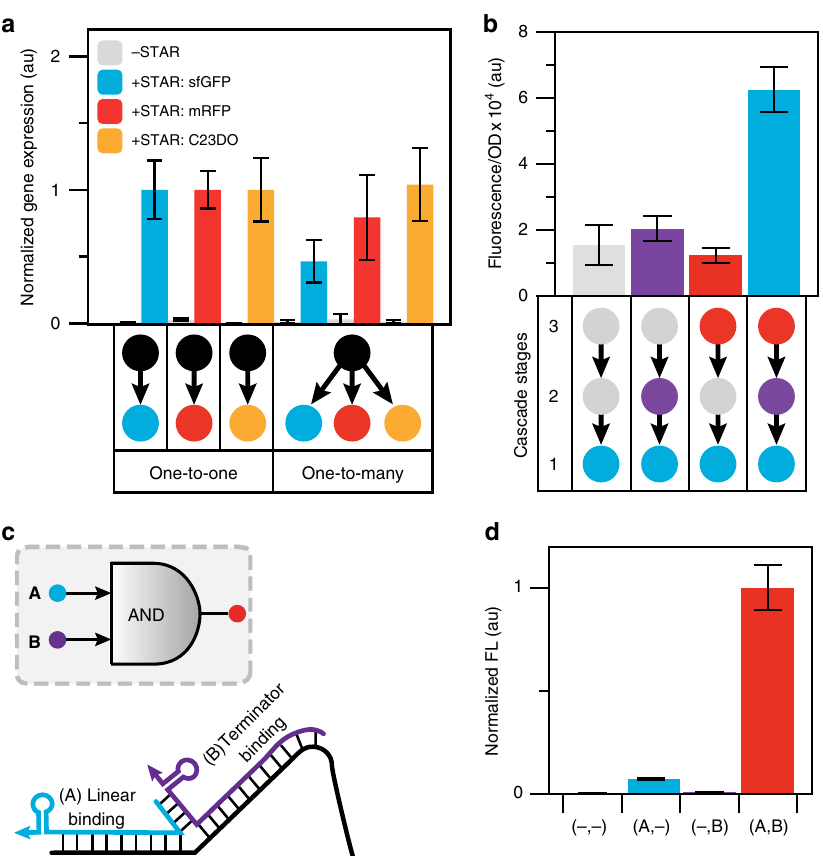
Fig. 5 STARs allow for new RNA-only network motifs. a A STAR single-input module (SIM) for one-to-many gene regulation. Fluorescence and spectral characterization of E. coli cells transformed with DNA plasmids encoding target RNAs controlling sfGFP, mRFP or catechol (2,3)-dioxygenase (C23DO) expression in the absence (-STAR) and presence (+STAR) of a plasmid encoding the cognate STAR. One-to-one characterization was performed on three different cell strains transformed with one of the plasmids encoding a single STAR regulated gene with and without the STAR plasmid. One-to-many characterization was performed on a single strain transformed with two plasmids encoding all three STAR regulated genes simultaneously with and without the STAR plasmid. C23DO expression level was determined as described in Supplementary Fig. 18. Measurements for each gene were normalized to 1 for the one-to-one value for that gene. b An RNA-only STAR activation-activation cascade. Fluorescence characterization was performed on E. coli cells transformed with combinations of DNA plasmids encoding cascade stages or control constructs. Cascade stage combinations used are shown in the schematic below the graph with grey indicating the use of a control DNA plasmid (Supplementary Fig. 19). c Schematic of a split STAR AND gate. STAR 1 was split into two regions corresponding to the linear and the terminator hairpin binding regions of the STAR (referred to as A and B), with a designed interaction sequence to promote the assembly of the full STAR complex (AB) when both are present. d Fluorescence characterization was performed on E. coli cells transformed with a DNA plasmid encoding a target RNA controlling sfGFP expression in the presence of a DNA plasmid encoding different combinations of A and B. Measurements were normalized to 1 for the AB condition. a , b Fluorescence characterization was performed by bulk fl uorescence measurements (measured in units of fl uorescence [FL]/optical density [OD] at 600 nm) and a spectral characterization. Raw data for the a spectral characterization is shown in Supplementary Fig. 18. d Fluorescence characterization was performed by fl ow cytometry (measured in units of Molecules of Equivalent Fluorescein [MEFL]). Data represent mean values and error bars represent s.d. of n = 9 biological